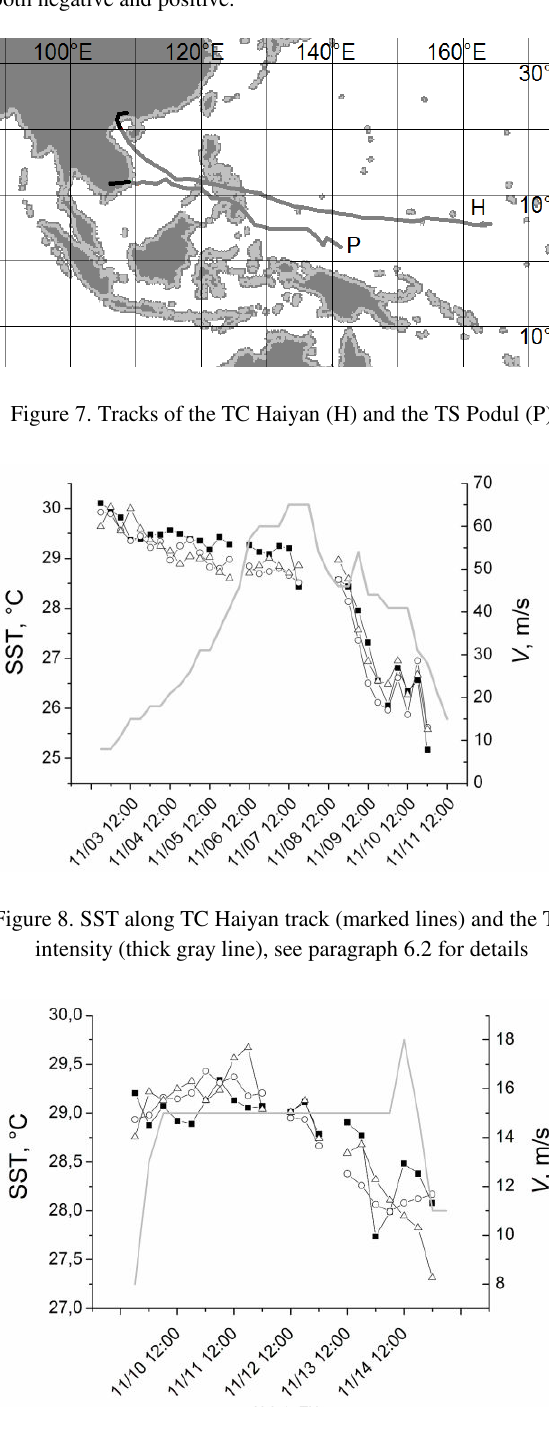
Figure 9. SST along TS Podul track (marked lines) and the TS intensity (thick gray line), see paragraph 6.2 for details Figure 10 illustrates the evolution of TC Haiyan intensity V , m/s (thick line, left axis) together with the synchronized estimations of the advective latent heat flux Q , MW (thin lines, right axis) during the whole TC lifetime. The integration contours used